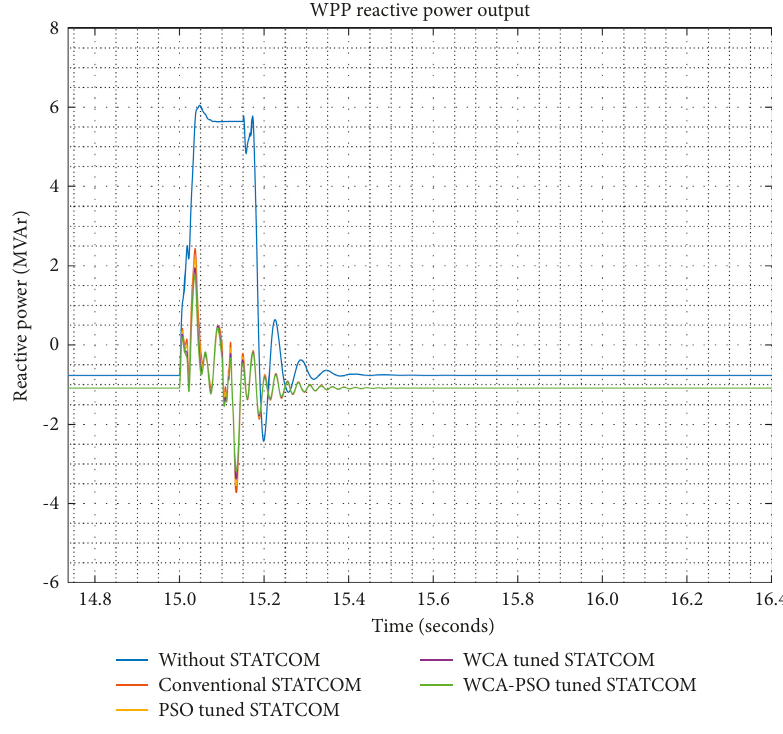
Figure 12: WPP reactive power output.